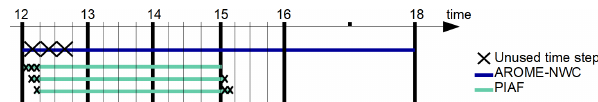
Figure 3. Example showing the unused time steps for a AROME- NWC forecast run starting at 12:00UTC and for three successive PIAF forecasts starting at 12:00, 12:05 and